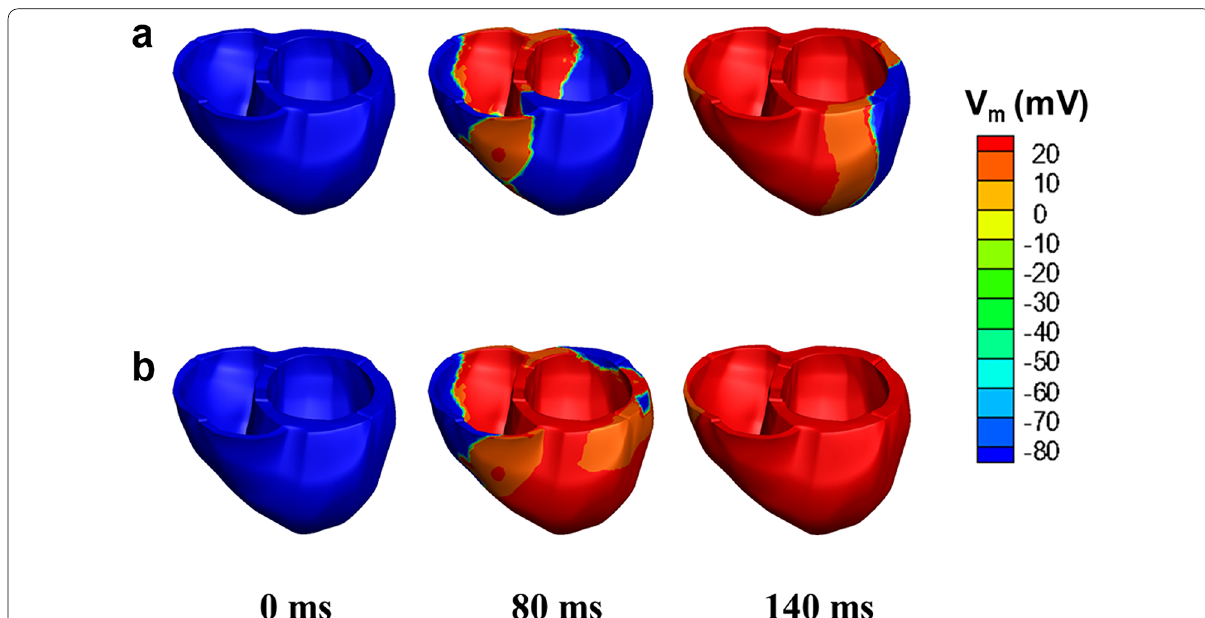
Fig. 5 The activation maps of ventricles under the LBBB ( a ) and CRT ( b ) conditions. While the RV was activated before the LV in the LBBB condition, both ventricles were activated almost simultaneously in the CRT condition. CRT block, LV left ventricle, RV right ventricle, V m membrane voltage = = =